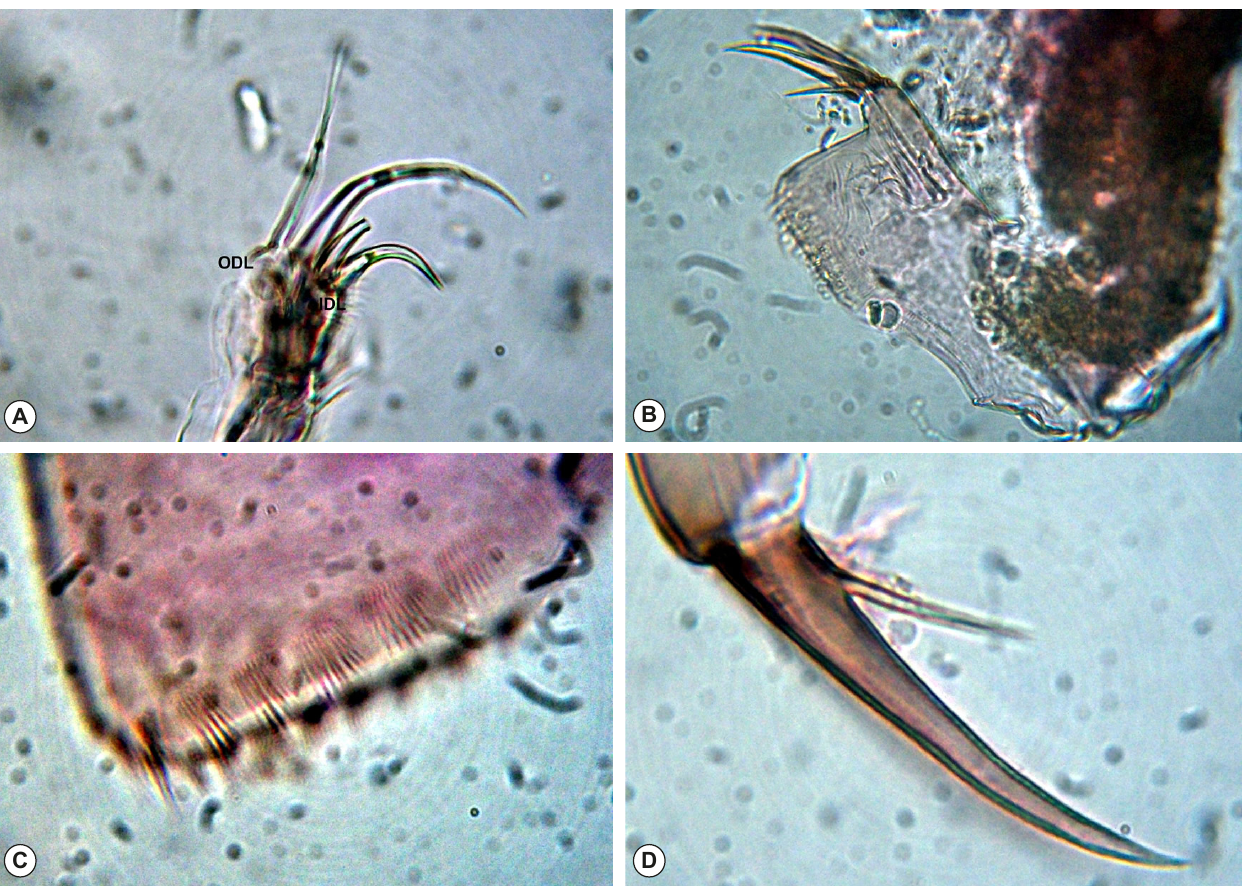
Figure 11. Nicsmirnovius fitzpatricki.